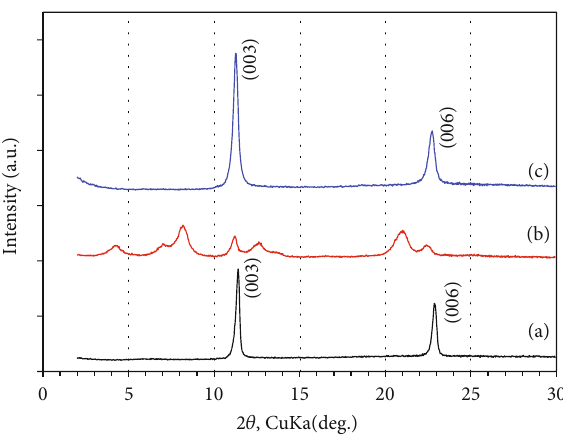
Figure 4: The XRD patterns of the (a) carbonate type LDH powder (black line), (b) PrO − type LDH powder (red line), and (c) LDH only fi lm (blue line).